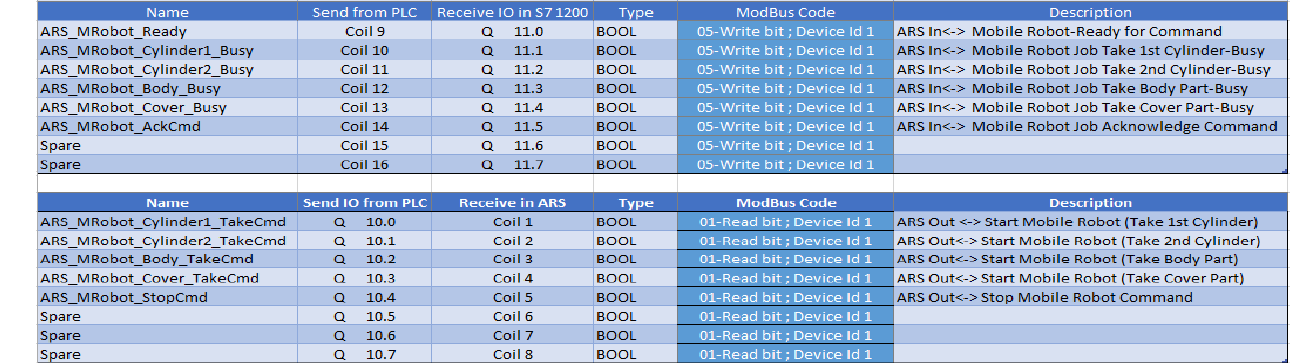
Figure 23. Modbus message interface (Modbus Map).